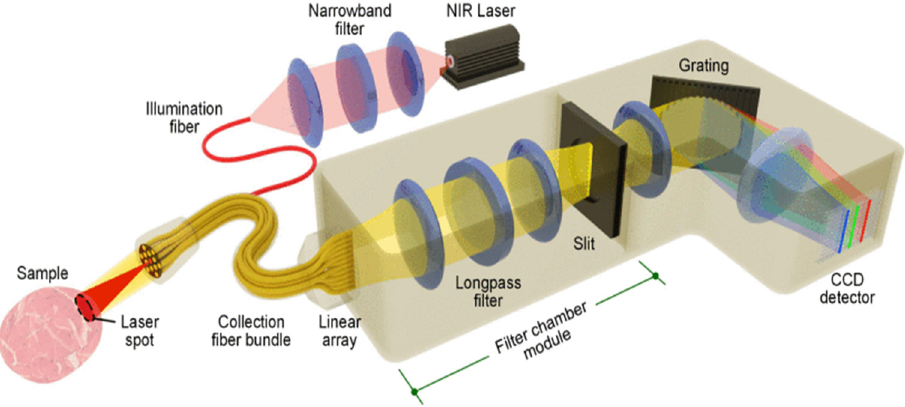
Figure 8. Typical experimental setup operating at NIR for SERS NP imaging in tissues. Reproduced with permission from [79]. Copyright 2016, IEEE.